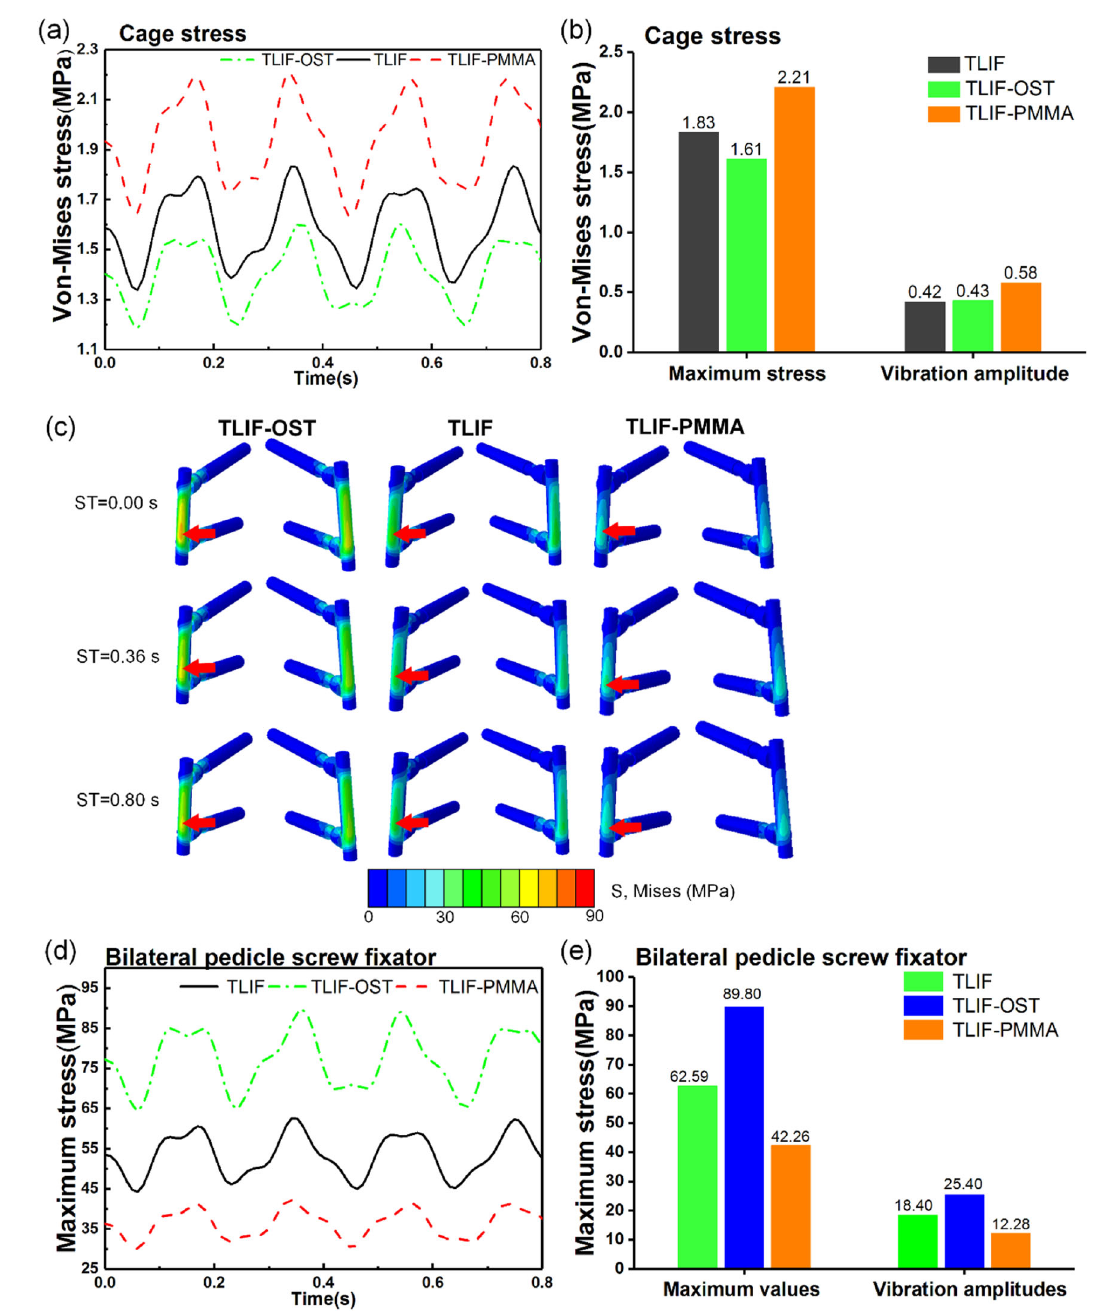
Fig. 6 Dynamic response of the maximum stress in the cage and bilateral pedicle screw for the fusion models. a the von Mises stress in the cage, b the maximum values and vibration amplitudes of the von Mises stress in the cage, c von Mises stress distributions of the bilateral pedicle screw in the TLIF, TLIF-OST, and TLIF-PMMA models when